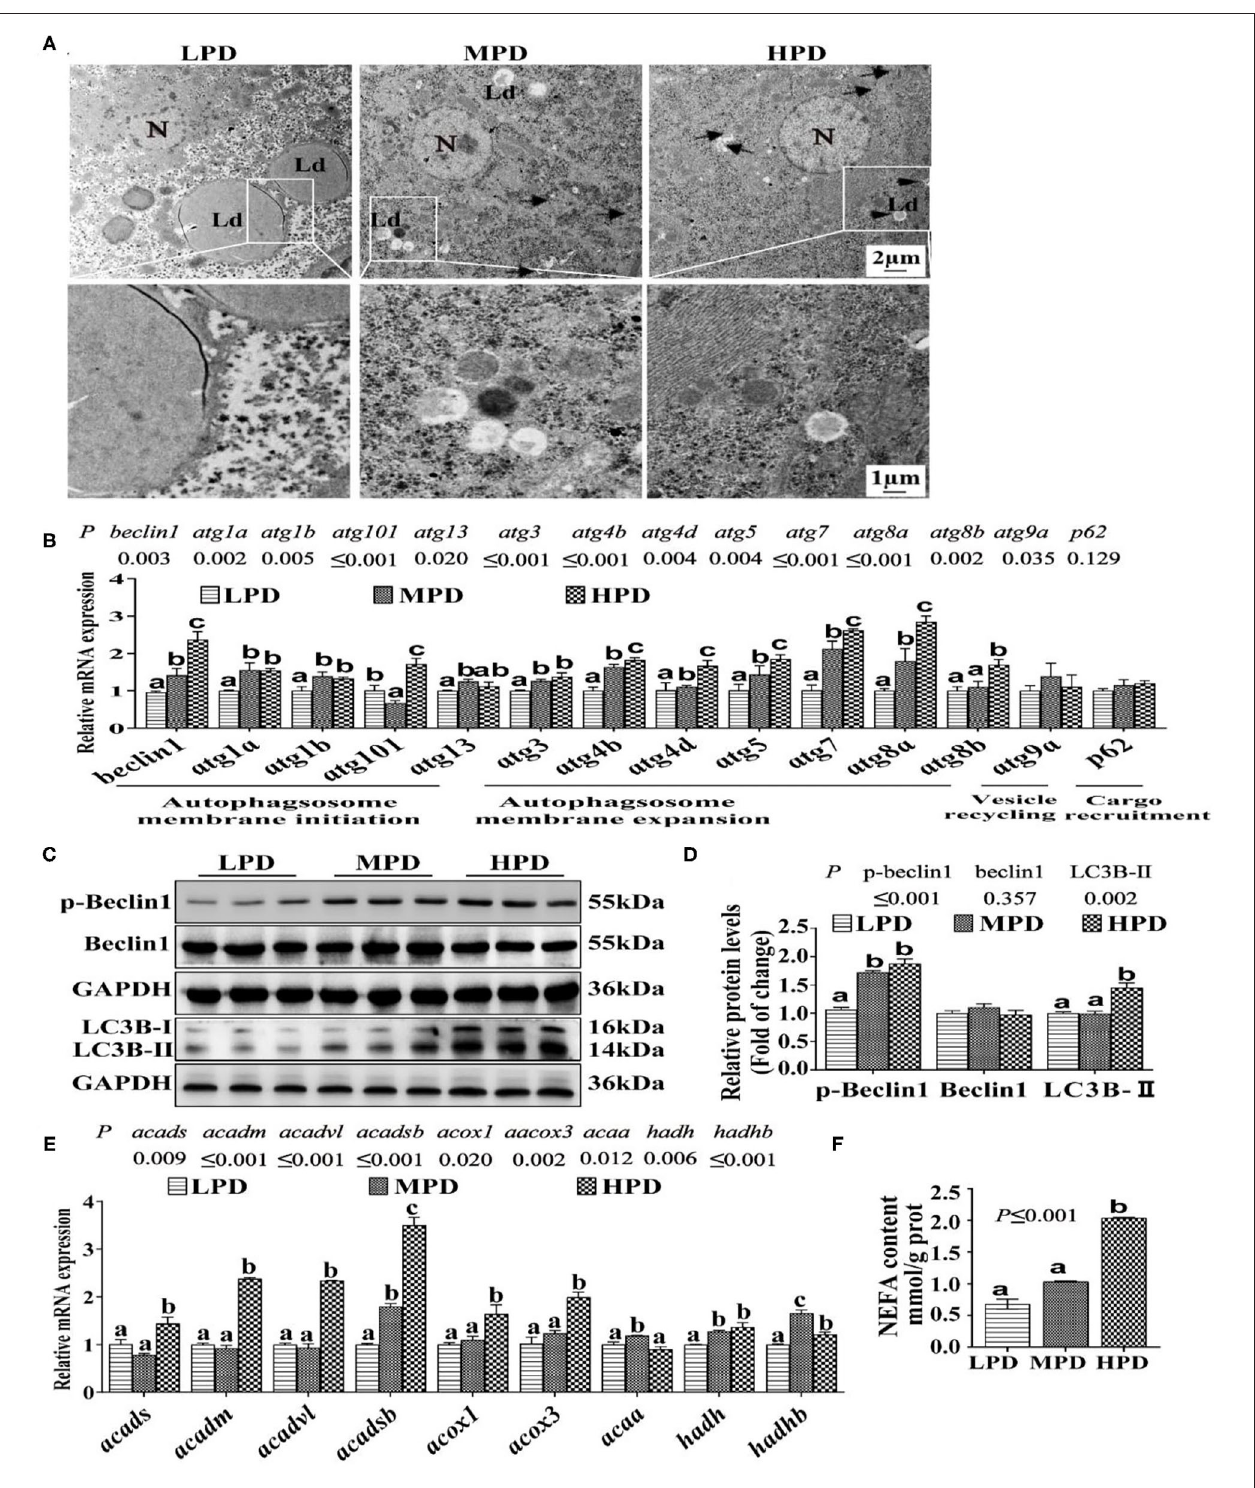
FIGURE 2 | Dietary phosphorus addition increased autophagosome formation in tilapia liver. (A) Representative image of liver ultrastructure (TEM). N, hepatocyte nucleus, Ld, lipid droplet. Arrows indicate the autophagosomes and autolysosomes. Arrowheads indicate the lipophagy. (B) Relative mRNA levels of genes related to autophagy. (C,D) Western blot analysis of Beclin1, p-Beclin1 and LC3B protein levels. (E) mRNA levels of the FA β -oxidation-related genes. (F) NEFA content. Data are mean ± SEM ( n = 3). “a-c” denote significance at P ≤ 0.05. The P Value was calculated by the one-way ANOVA and further the post-hoc Duncan’s multiple range